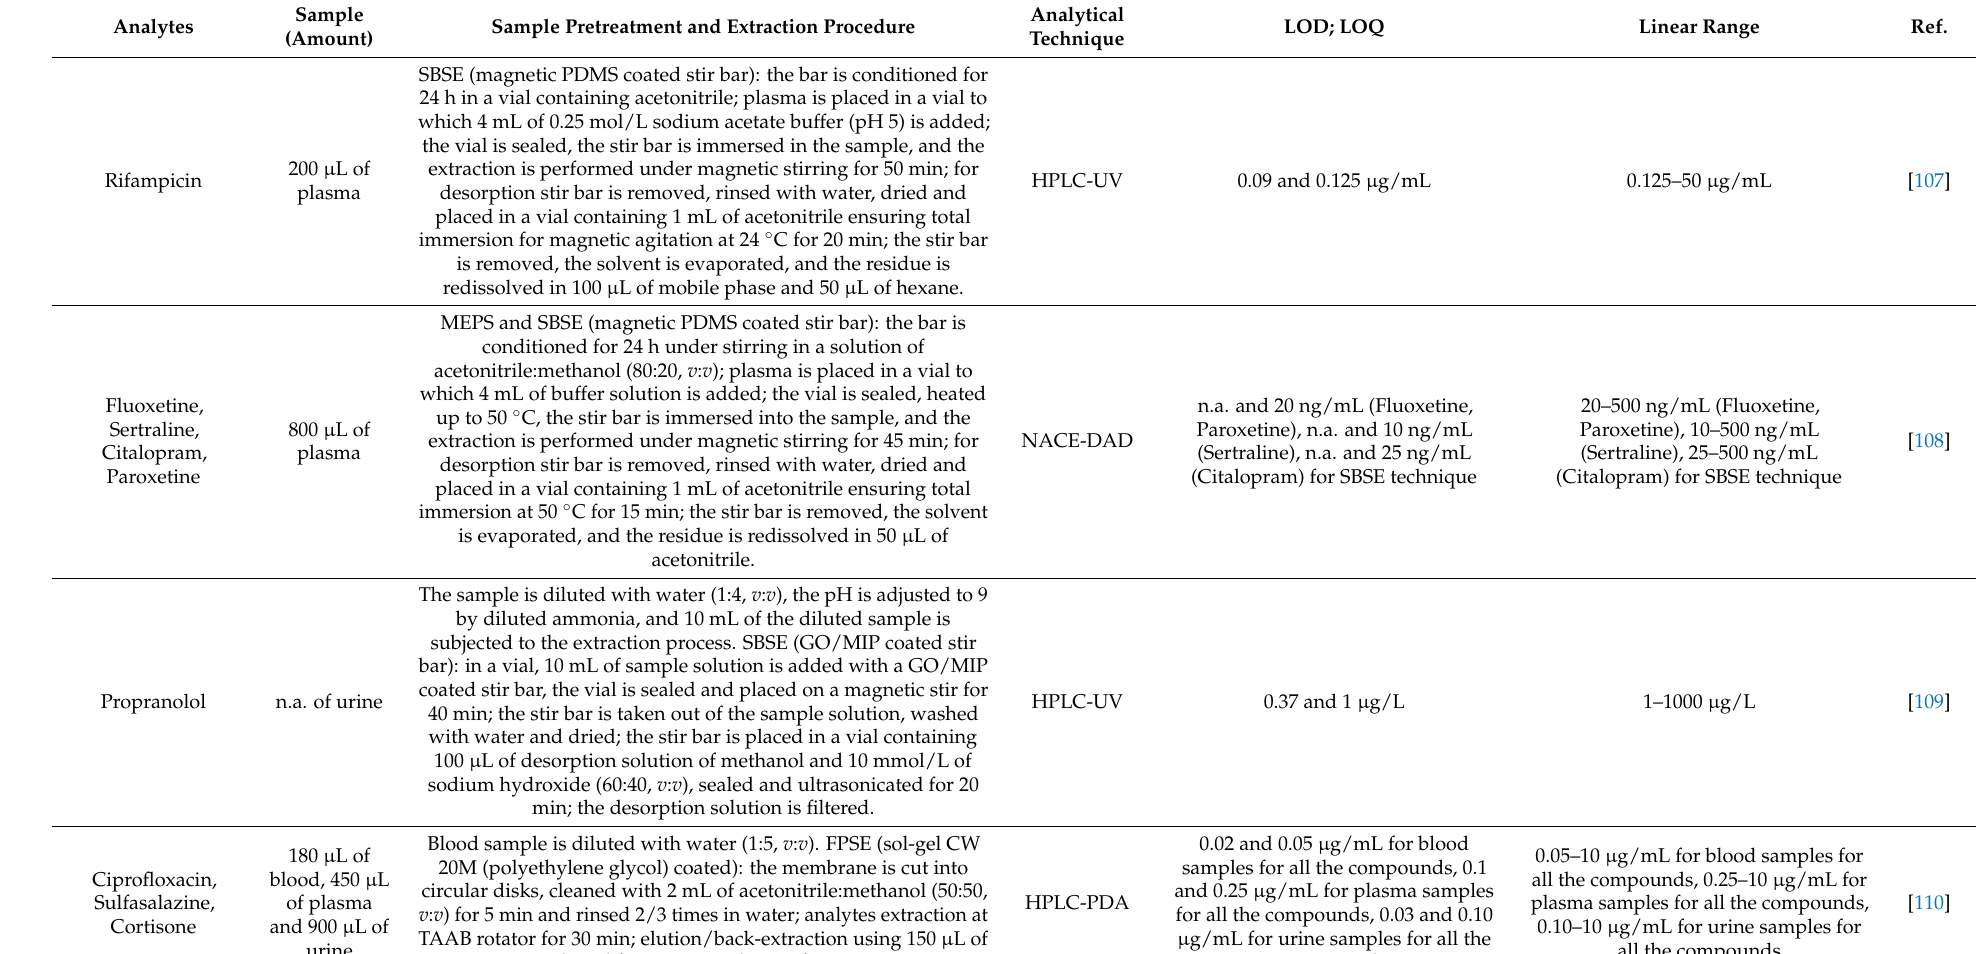
Table 12. Bioanalytical procedures using SBSE and FPSE approaches for